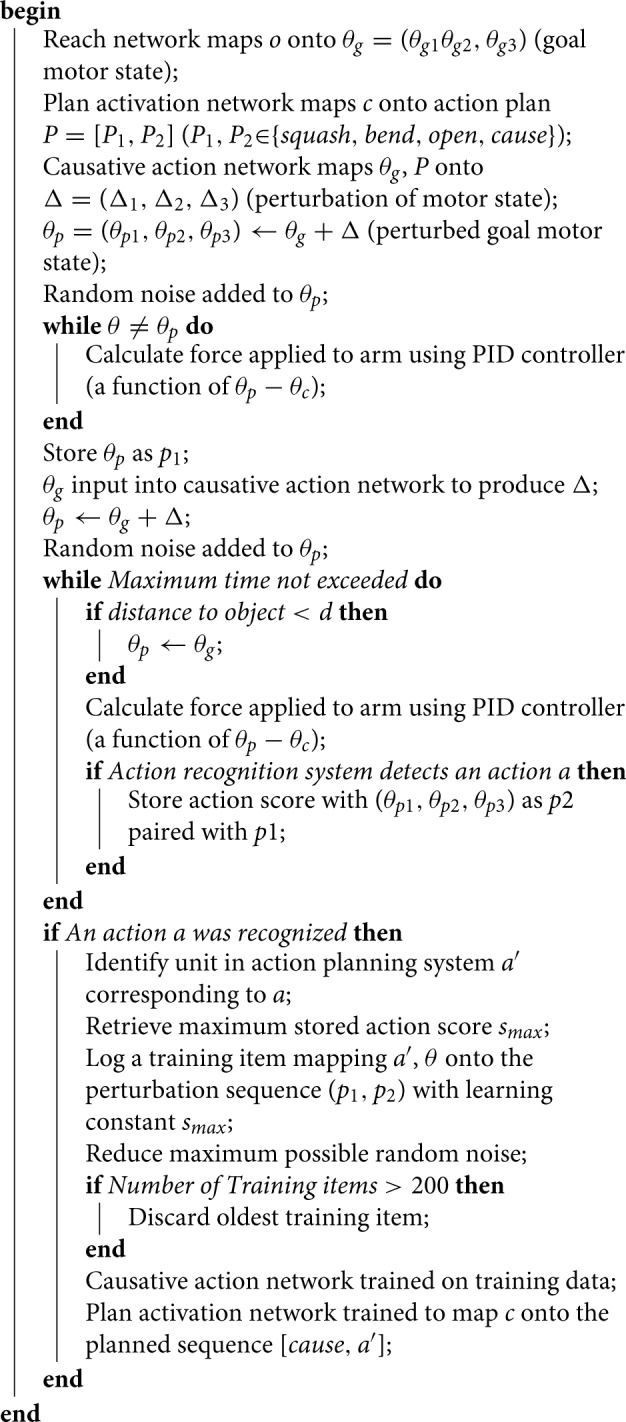
Learning causative actions.